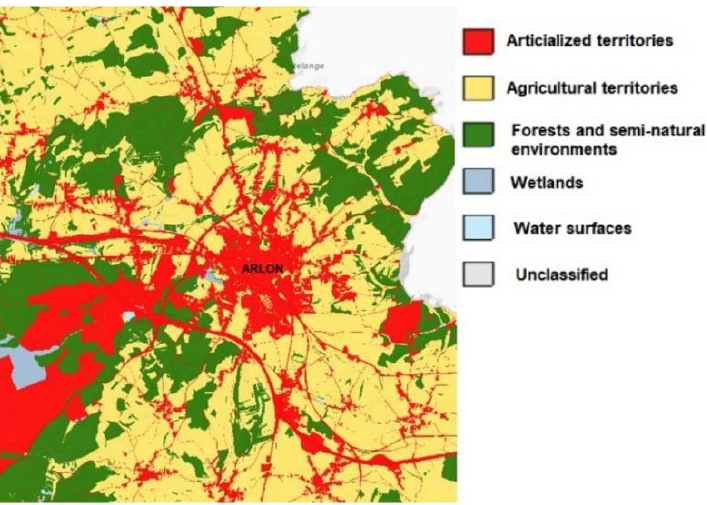
Figure 2. Land use around Arlon (Service Public de Wallonie, COSW 2007 (1 January 2008). Scale 1/75.000. Produced by Claudia Falzone. Using Cigale © SPW — 2021 (13 January 2021)).